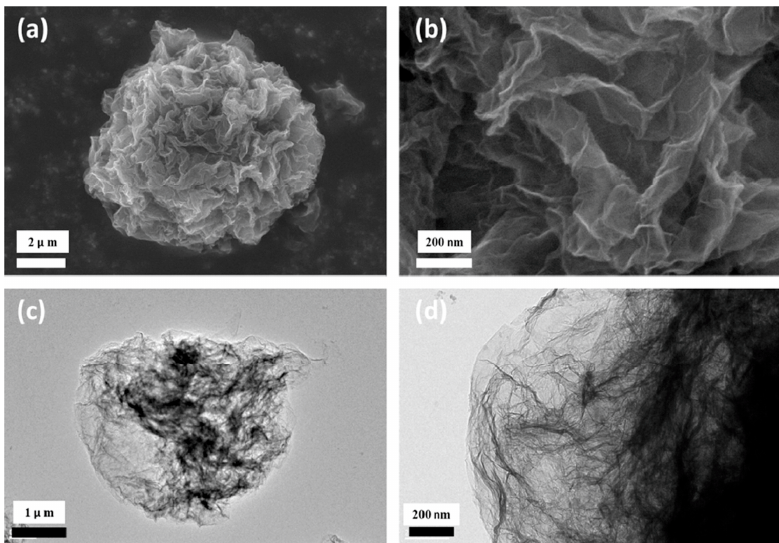
Figure 11. Graphene network after chemical etching of the Na 3 V 2 (PO 4 ) 3 phase: ( a , b ) SEM images; ( c , d ) TEM images. (Reproduced with permission from [344] . Copyright (2017) American Chemical Society.).